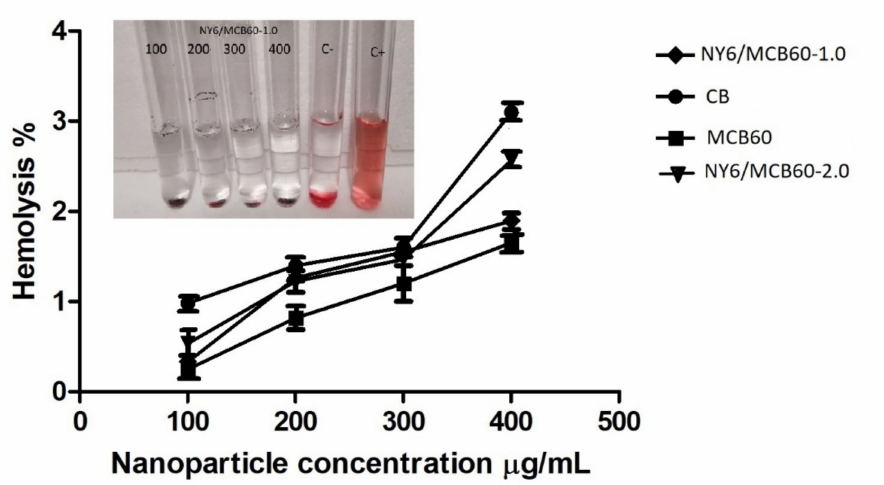
Figure 7. Hemolysis study results of CB, MCB60 and NY6 / MCB60 nanocomposites (concentrations of 100, 200, 300, and 400 µ g / mL; C-, negative control; C + , positive